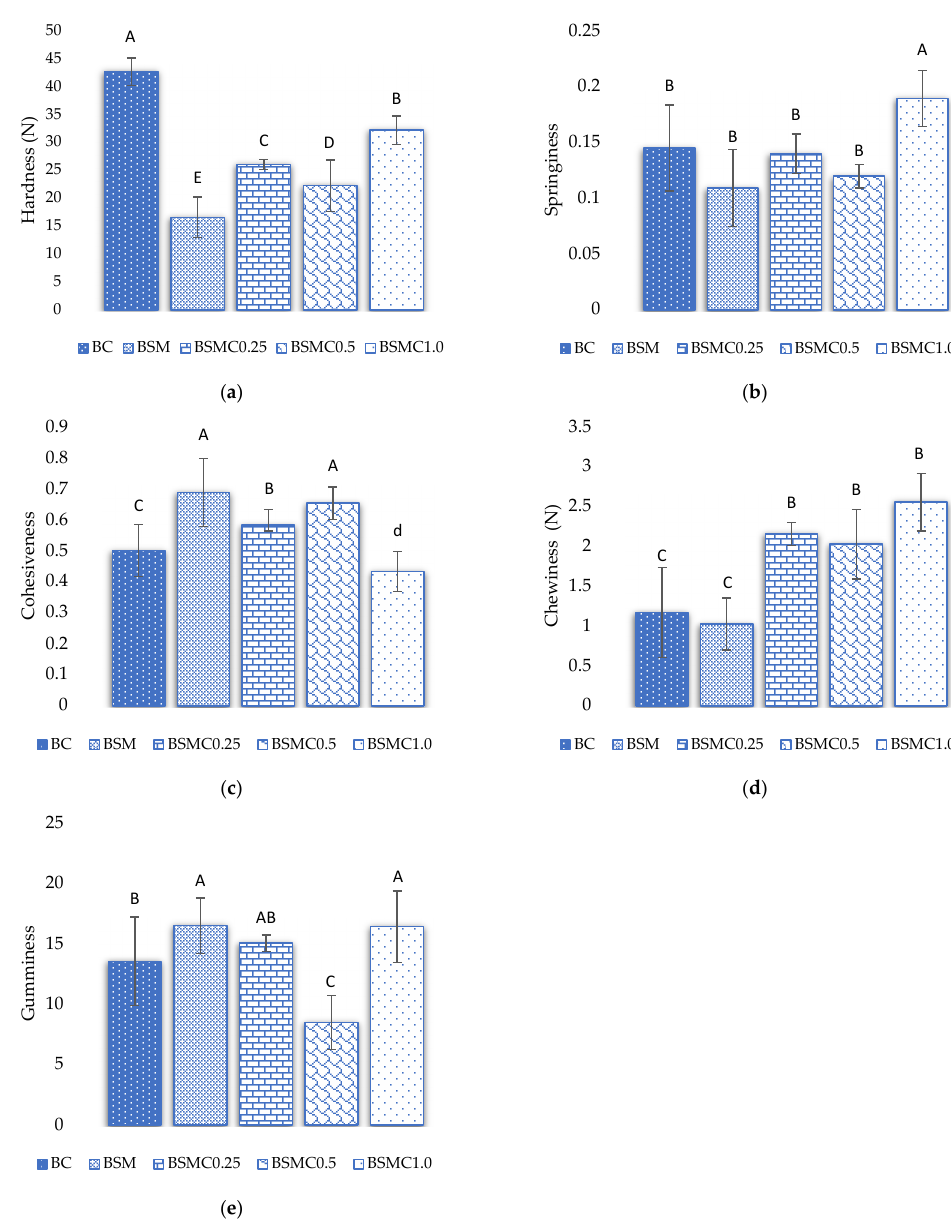
Figure 1. Effect of partial replacement of pork backfat with a gelled emulsion of maca flour, soybean oil, and chincho essential oil on the textural parameters of beef burger. ( a ): hardness; ( b ): Springine- ness; ( c ): Cohesiveness; ( d ): Chewiness; ( e ): Gumminess. (A-E) Equal capital letters on the same bars indicate that there is no significant different according to Tukey’s HSD post-hoc test ( p > 0.05). PB: pork backfat; GE: gelled emulsion BC: control hamburger with a traditional formula (20% PB); BSM: burger with 10% PB and 10% substituted by GE 1 with maca flour and soybean oil; BSMC0.25: burger with 10% PB and 10% substituted by GE 2 with maca flour, soybean oil, and chincho essential oil;